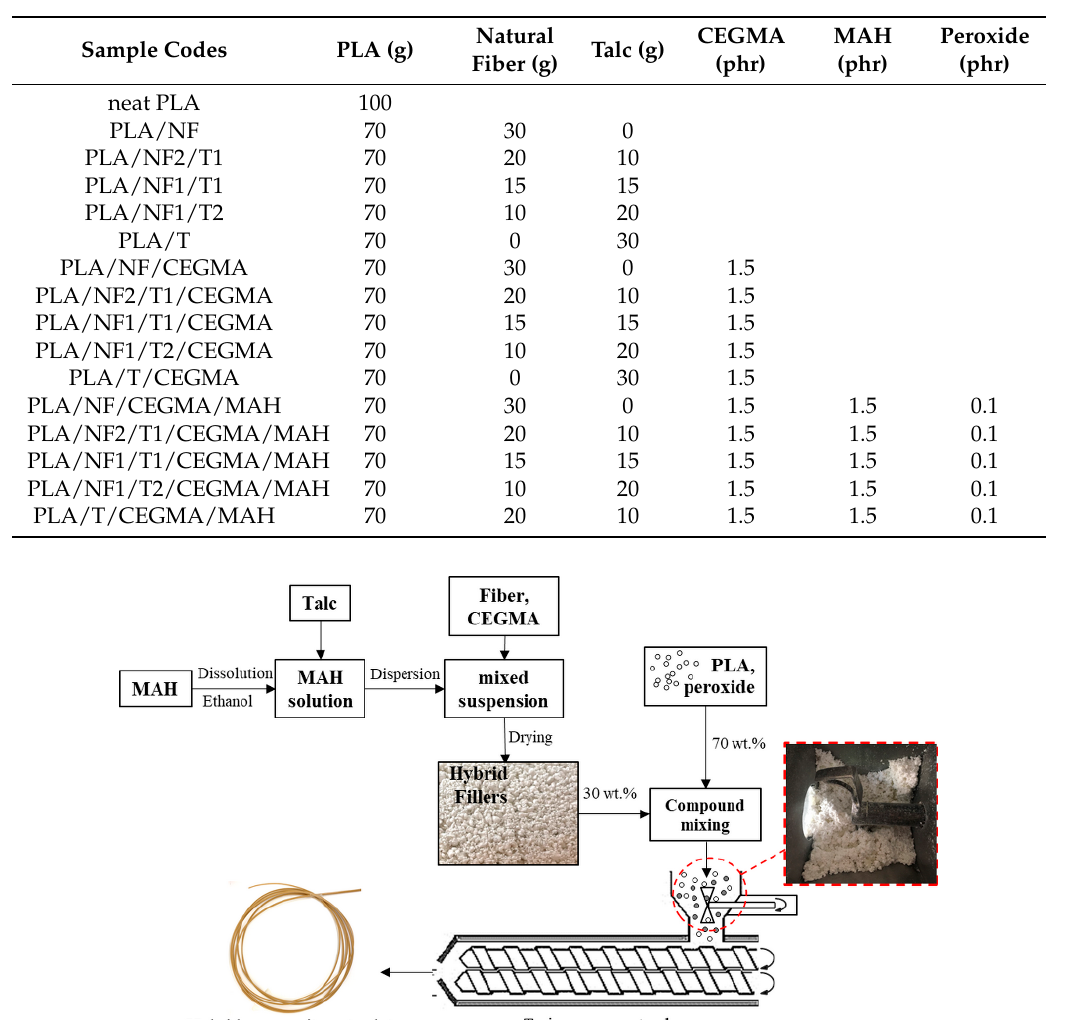
Table 1. List of material compositions for extrusion compounding.